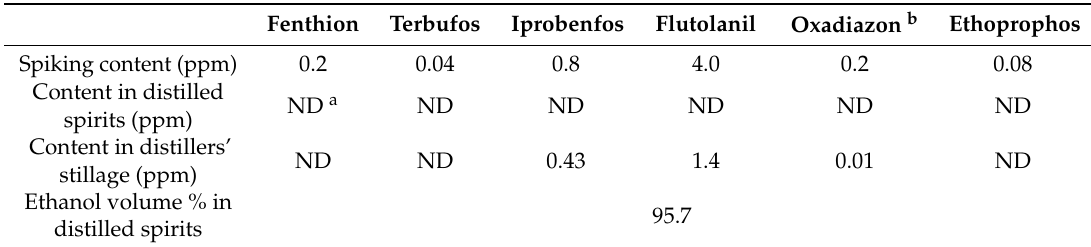
Table 3. Content (ppm) of contaminated pesticides in the distilled spirits and distillers’ stillage from the pilot-plant scale in the distillation column experiment. Fenthion Terbufos Iprobenfos